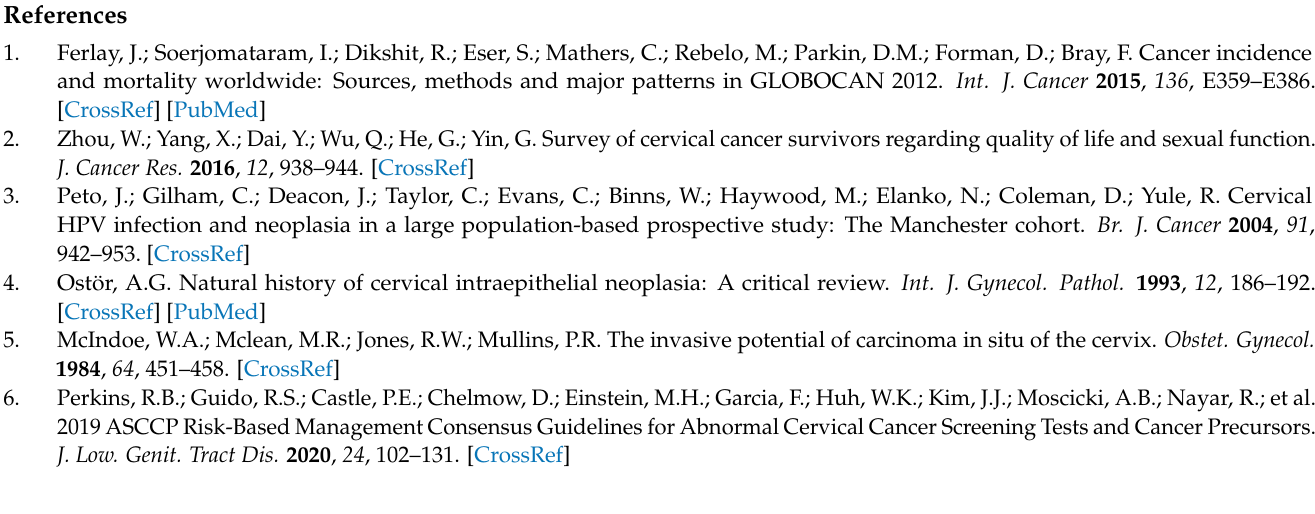
tometry; Figure S2: Physical and chemical characterization of the NIPP effluent used in tissue and patient treatment, Figure S3: Raman microspectroscopy and PCA show cellular changes after NIPP treatment by noninvasive fingerprinting; Figure S4: Tissue substructures can be visualized in a marker-independent manner by Raman imaging. Figure S5: PCA of the nuclear features of in vivo NIPP-treated tissues demonstrates NIPP-induced cellular changes in superficial and basal tissue layers; Table S1: Patient characteristics for ex vivo NIPP treatment; Table S2: Raman shifts and their molecular assignments, Table S3: Patient characteristics for in vivo NIPP treatment; Movie S1: In vivo application of NIPP. References [37–47] are cited in the Supplementary